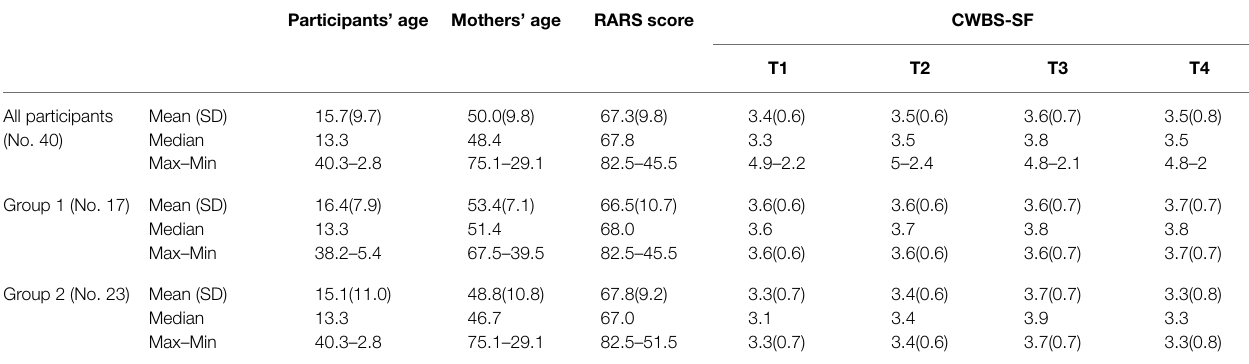
TABLE 1 | Descriptive statistics of participants’ and parents’ age, RTT severity level (RARS), and CWBS-SF score. Participants’ age Mothers’